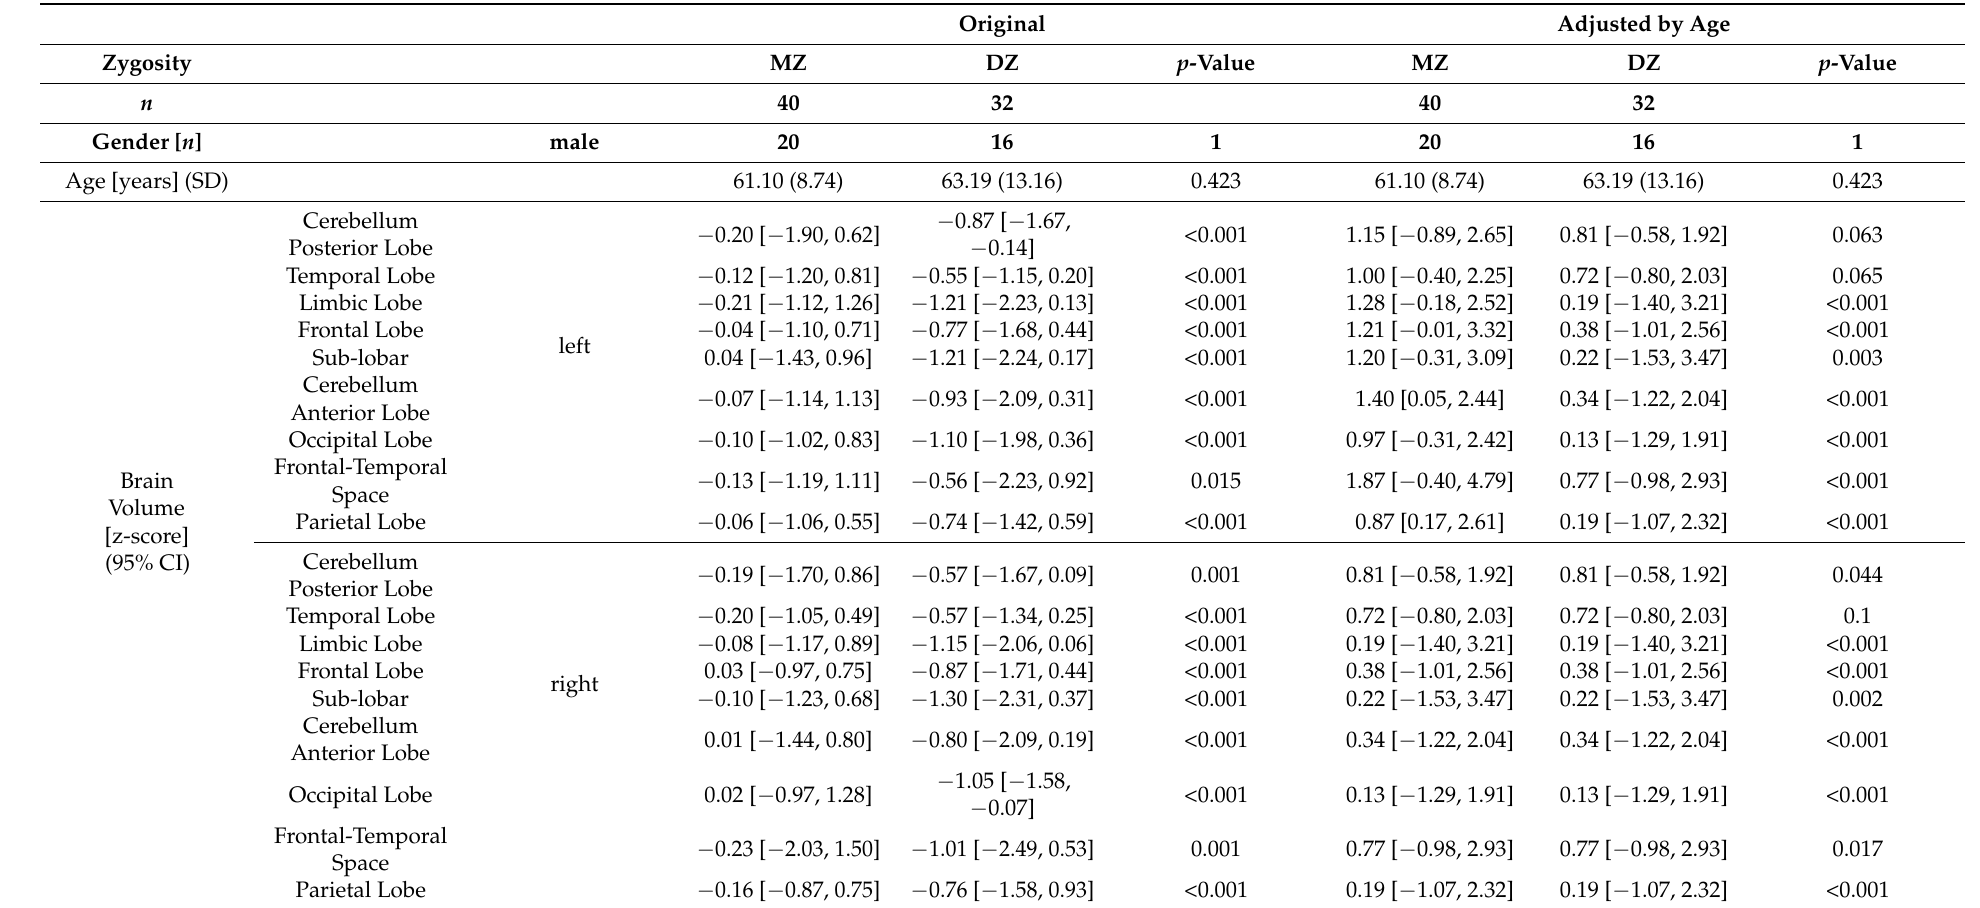
Table 1. Comparison of variables between types of twin zygosity according to